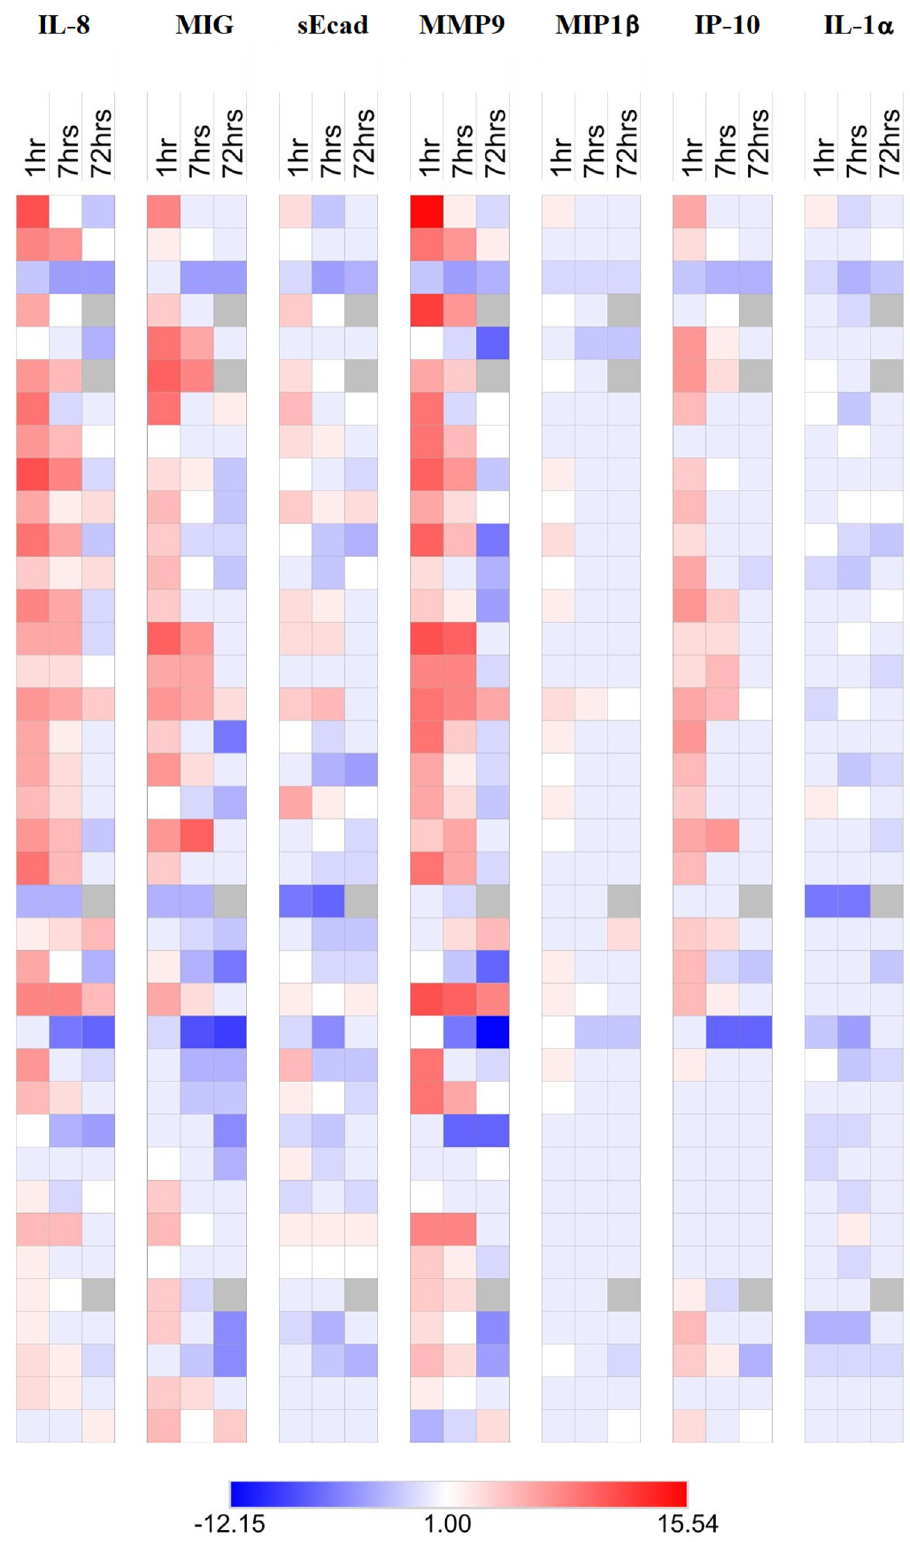
Fig 3. Penile cytokine changes after sex. The penile cytokine changes 1 hour, 7 hours and 72 hours after sex (condomless and condom-protected). Penile cytokine changes are presented as log2 transformed fold